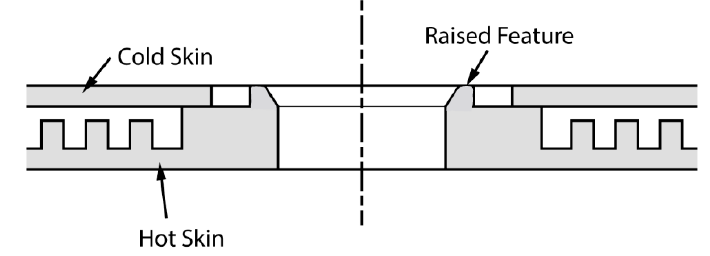
Figure 11. Method to avoid inlet step effects on discharge coefficient.